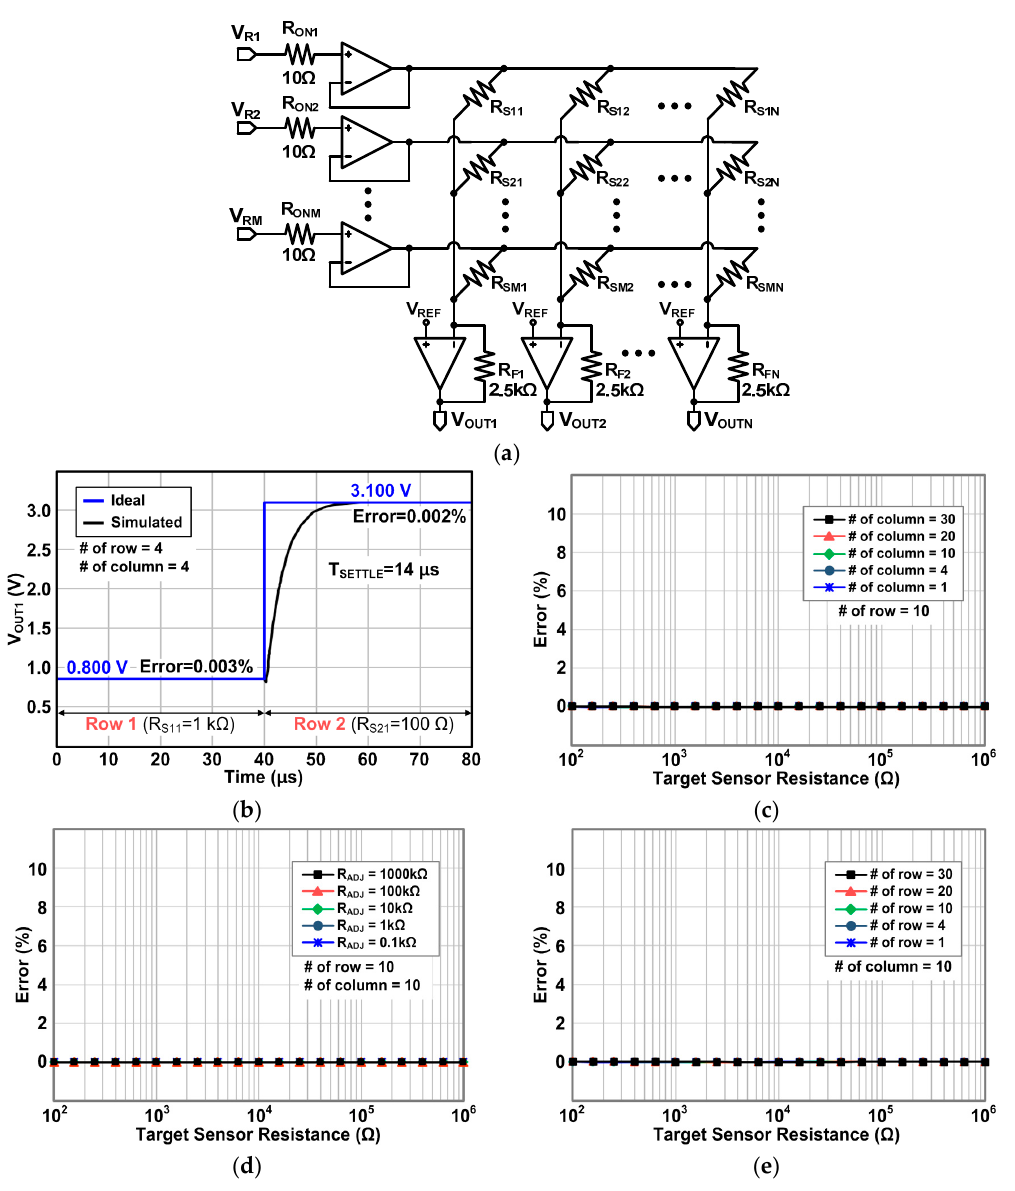
Figure 11. ( a ) Schematic for the simulations of the Type II row driver, ( b ) transient simulation results, ( c ) output errors as a function of the sensor resistance with different column numbers, ( d ) output errors as a function of the sensor resistance with different adjacent sensor resistance (R ADJ ), and ( e ) output errors as a function of the sensor resistance with different row numbers.